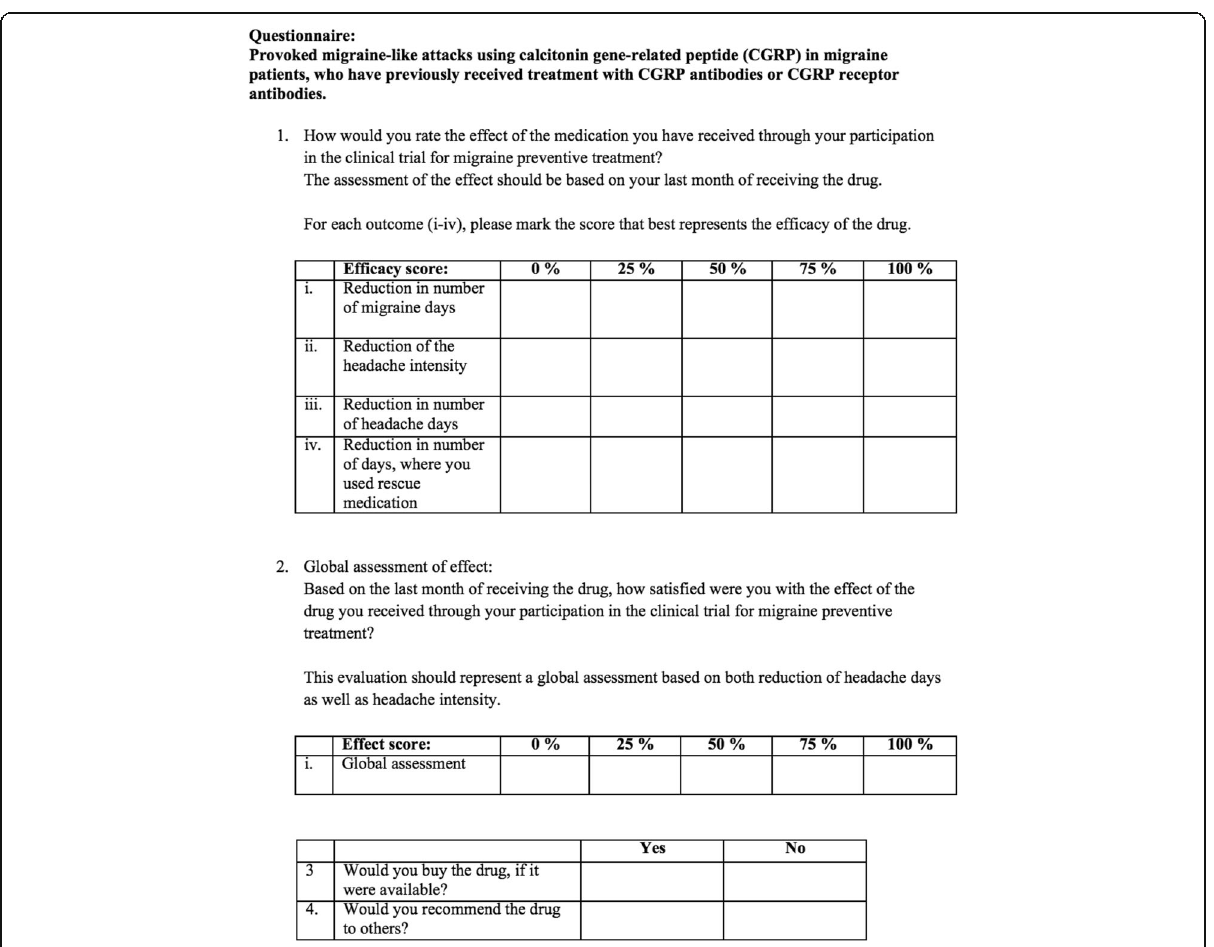
Fig. 2 Questionnaire used for monoclonal antibody response stratification. Patients who reported excellent effect of treatment (efficacy score ≥ 50%) in at least two of the four outcome variables (i-iv) were defined as high responders. The remaining patients were defined as poor